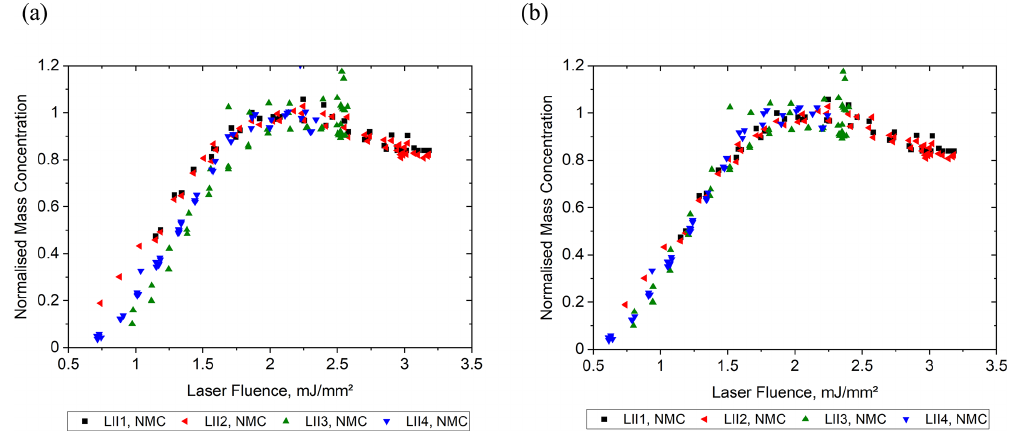
Figure 6. Normalised mass concentration (NMC) mean across the different laser fluence measured from the kerosene-fuelled Rig A by multiple LII instruments (LIIs 1 to 4): (a) original output from the multiple LII instruments and (b) the laser fluence axis of instruments LII 3 and LII 4 was shifted to fit the data from LII